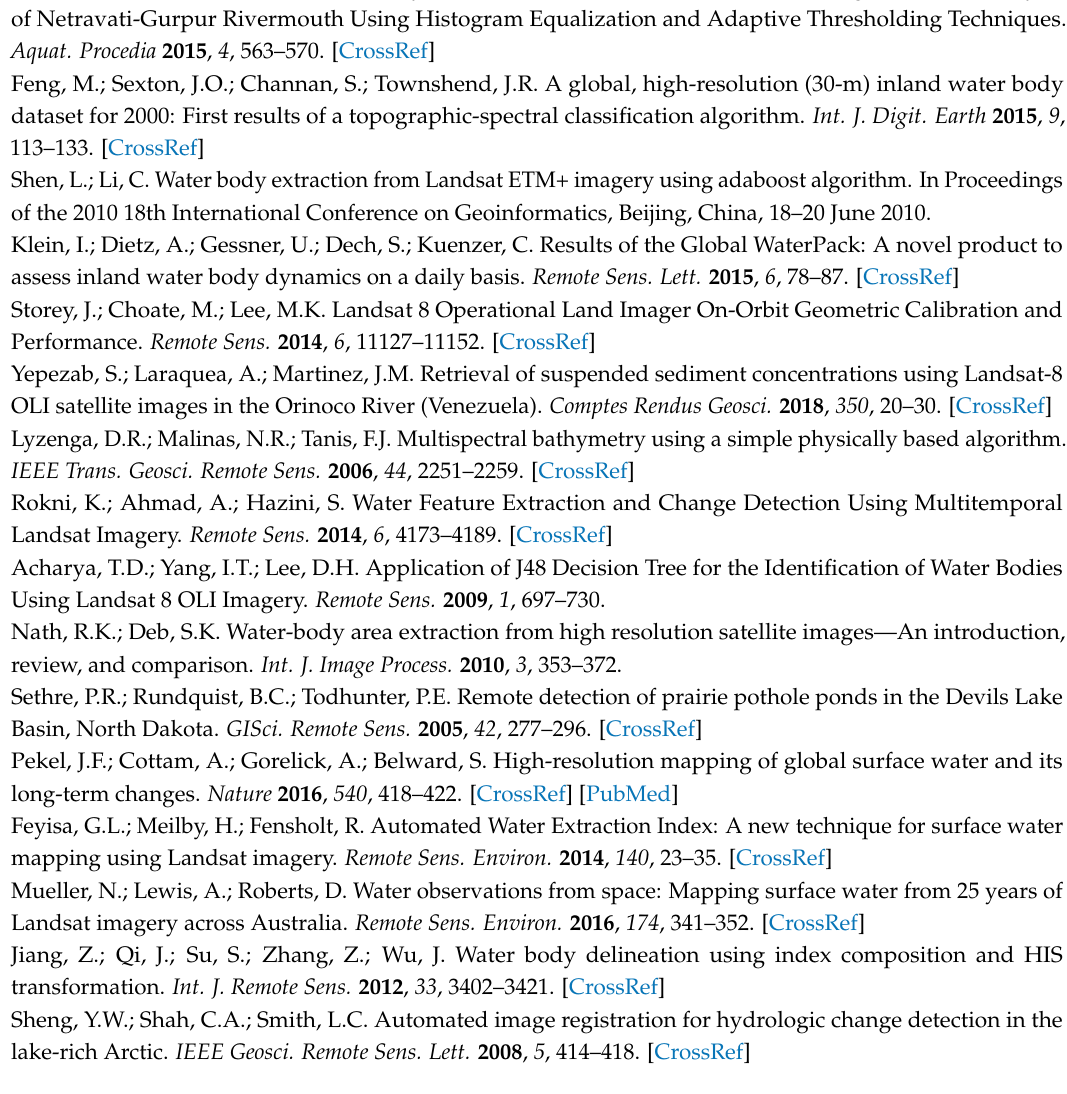
Figure B7. Water/non-water region estimation using Landsat-8 image collected on 2016-10-30. Figure A7. Water/non-water region estimation using Landsat-8 image collected on